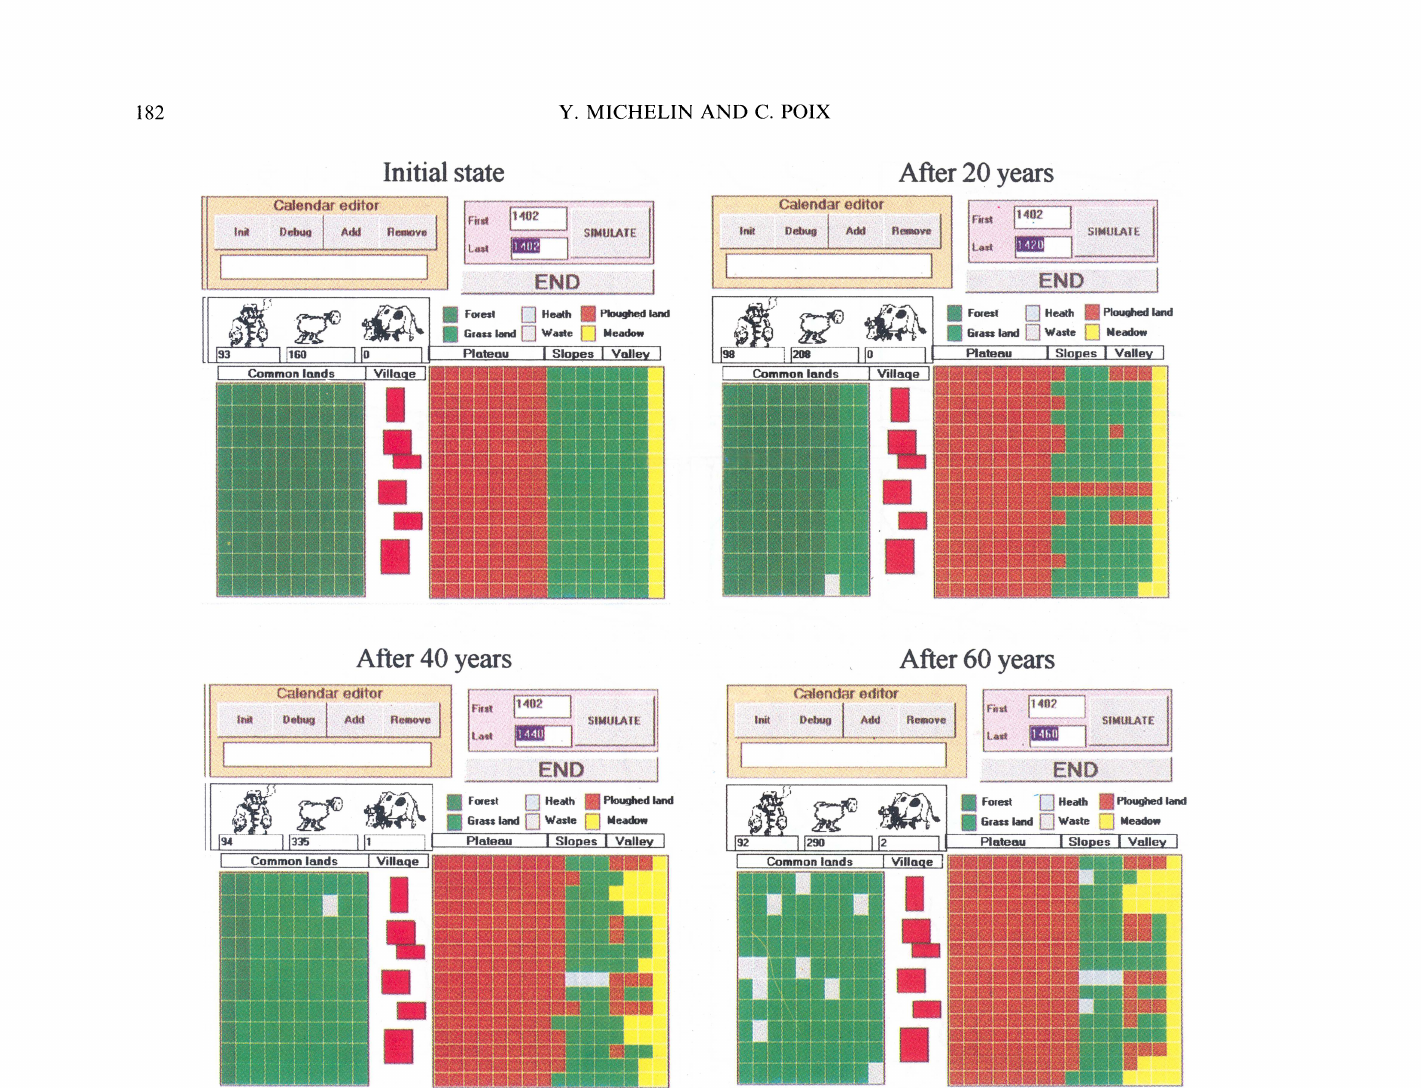
FIGURE 4 Simulated maps of land use at different times. (See Colour Plate